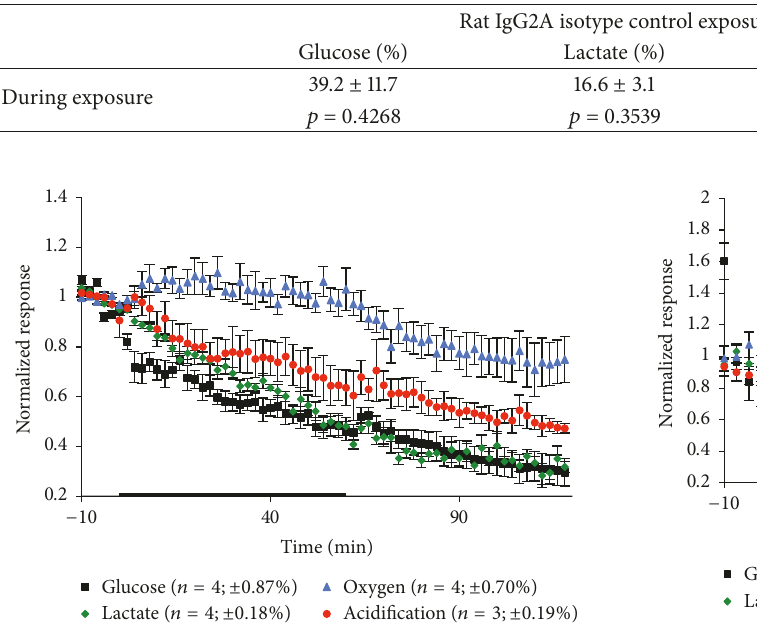
Figure 8: Average metabolic response of RAW 264.7 cells to a 10 min exposure of 25 𝜇 g/mL rat IgG2A isotype control. The black bar indicates the exposure time. The number of experiments and standard error of the mean for the basal metabolic rate 10min before exposure to the antibody are given in